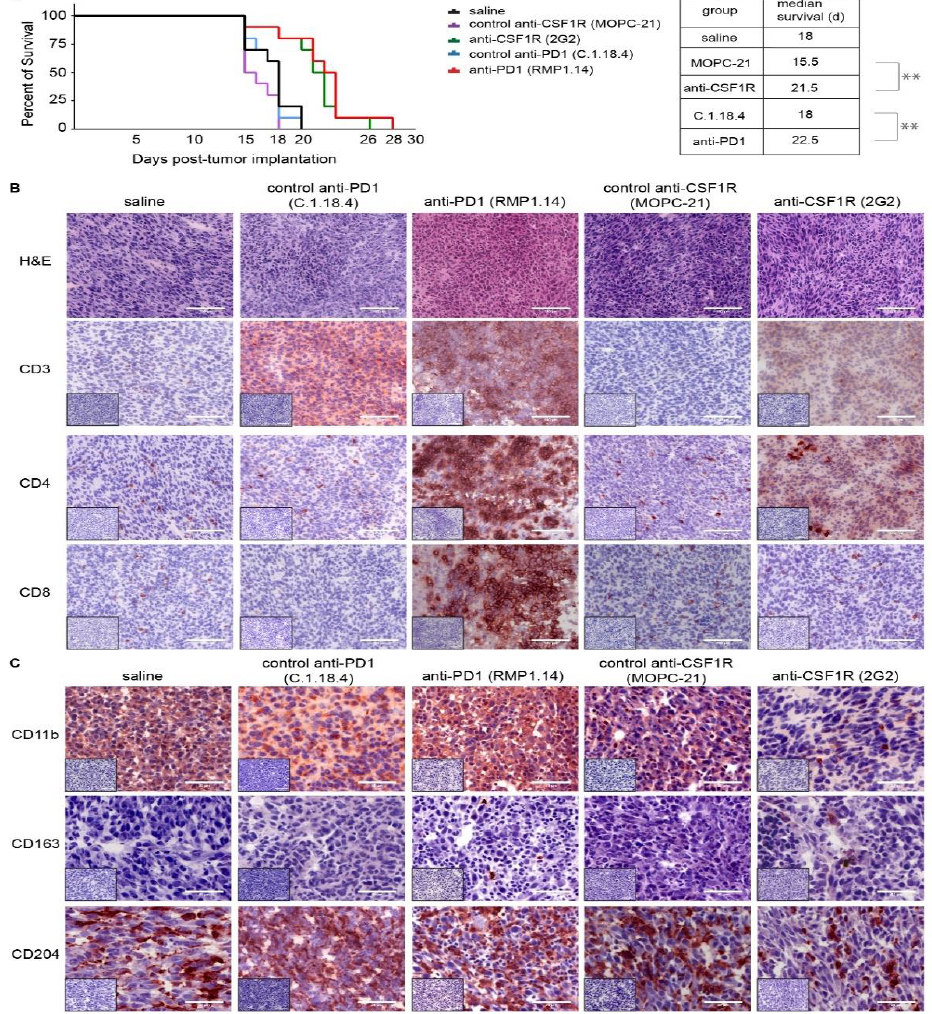
Figure 2. Monotherapies with PD1 and CSF1R blockade in experimental syngeneic SMA-560 glioma in vivo. ( A ): Kaplan – Meier plot showing symptom-free survival. Experimental groups ( n = 10 in each group) include control treatment (saline), anti-CSF1R (2G2) antibody, anti-PD1 (RPM1.14) antibody, and respective control antibodies. Treatments started on day 14 post-tumor implantation. Tukey – Kramer post hoc test was used after performing Log-rank (Mantel – Cox) test ( p < 0.001). ** p < 0.001 Survival time depicted in Kaplan – Meier plot refers to experimental endpoint as described in detail in material/methods section and in Supplementary Table S1. ( B , C ): Immunohistochemical analysis in post-treatment SMA-560 gliomas of one representative animal per group ( n = 1). Small inserts show staining control without application of primary antibody. (scale bars in ( B ) : 100 μm; scale bars in ( C ) : 50 μm).